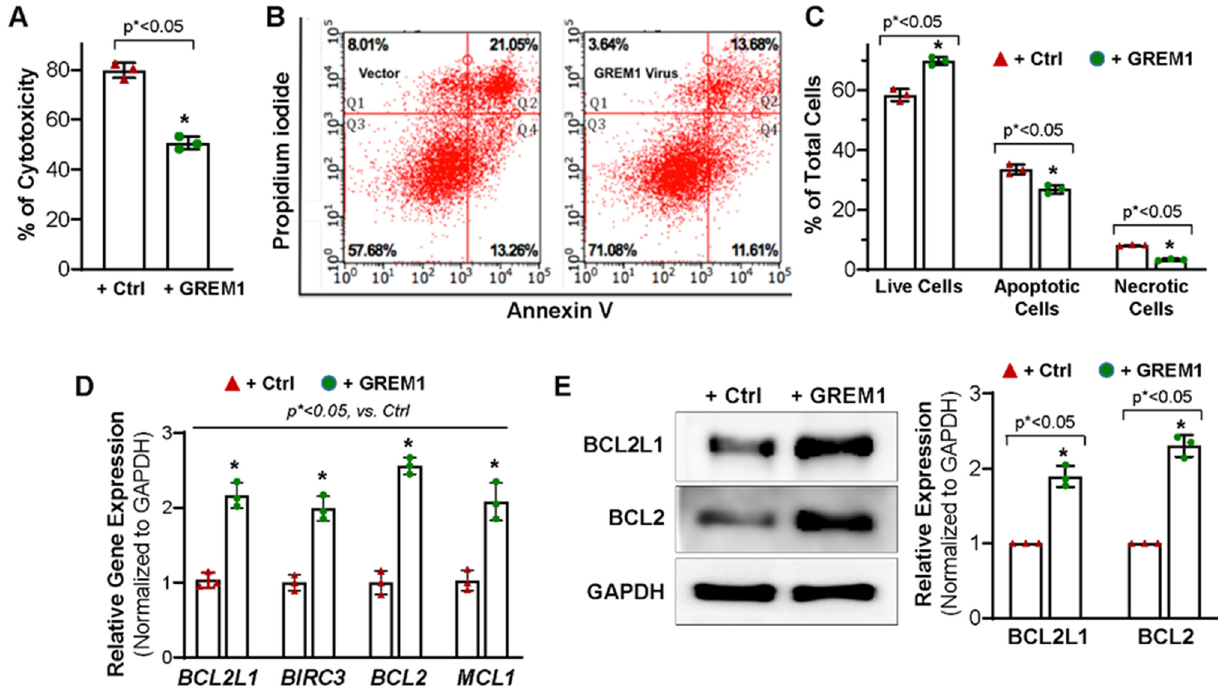
Figure 3. Overexpressing GREM1 enhances the survival capacity of the hMPCs and increases the expression of anti-apoptotic genes and protein. ( A ) Overexpressing GREM1 in hMPCs significantly increased the cell survival capacity, as indicated by the decreased LDH release. ( B ) FACS analysis with annexin V/PI staining shows a significant increase in the number of live cells (Q3) and a decrease in the number of apoptotic cells (Q2 + Q4) and necrotic cells (Q1) after overexpressing GREM1 in hMPCs compared to the control cells. ( C ) Quantitative analysis for panel B. ( D ) Real-time quantitative PCR analysis with an anti-apoptotic primer library screening shows a significant increase of the indicated anti-apoptotic gene expression following 48 h of overexpressing GREM1 in hMPCs versus control cells. ( E ) Western blot analysis showed the protein level of BCL2L and BCL2 in hMPCs with overexpressing GREM1 versus control cells. Data are mean ± SEM. p value was calculated by unpaired Student’s t -test, n = 3 independent experiments. * indicated the significant difference compared to the control group.